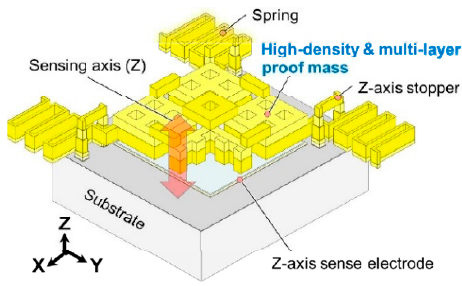
Figure 9. Schematic diagrams of the MEMS accelerometer developed by Yamane et al . at Tokyo Institute of Technology [42].